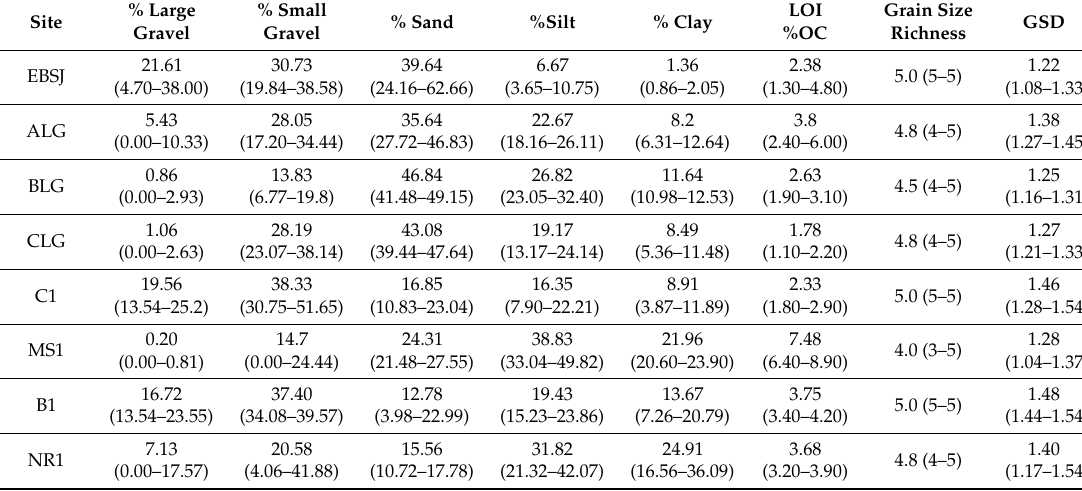
Table 2. Mean values and minimum–maximum values (in parentheses) of eight physical characteristics of sediment from eight agricultural headwater streams in Indiana, Michigan, and Ohio, 2017 to